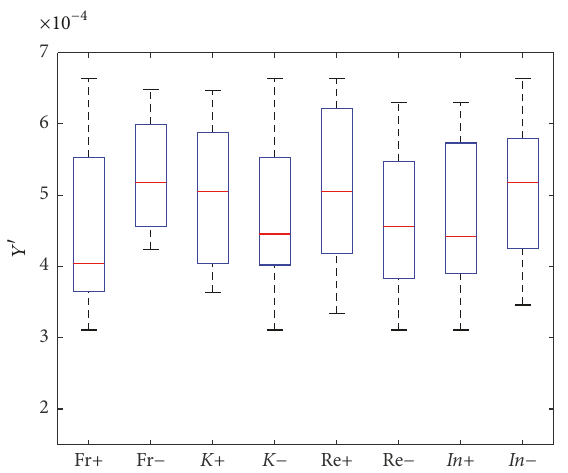
Figure 15: Boxplot of the 𝑌 󸀠 position at 𝑋 󸀠 = 1.125×10 −3 for a plate with a starting positive angle orientation.